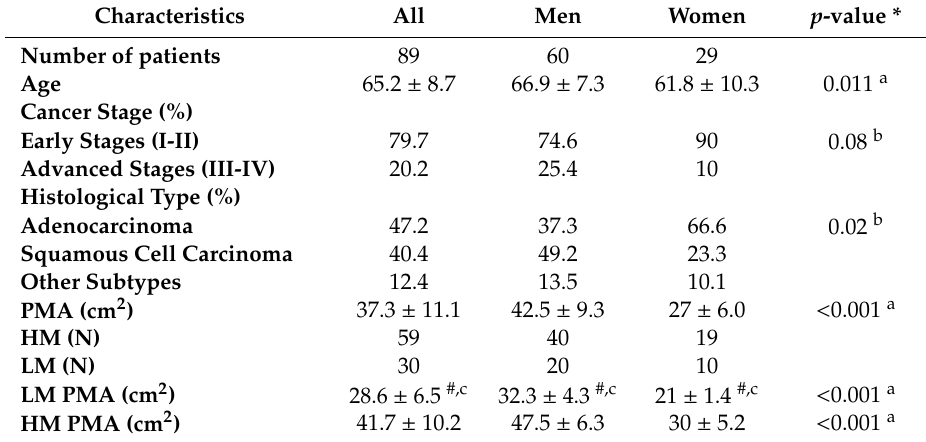
Table 1. Clinical findings and skeletal muscle parameters of patients with NSCLC (non-small cell lung cancer) with low- and high-muscularity defined by pectoralis muscle cross-sectional area assessed by computed